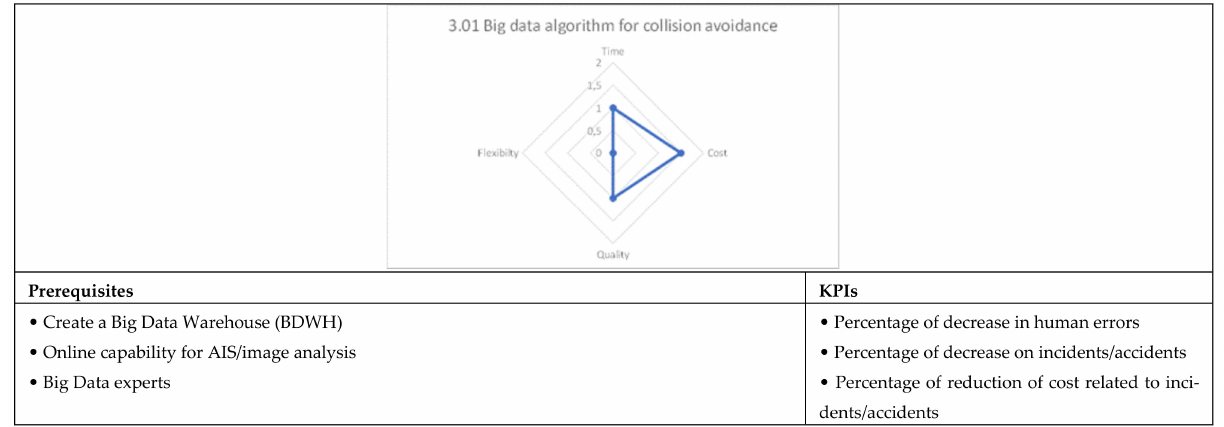
Figure A27. Big data algorithm for collision avoidance data sheet.